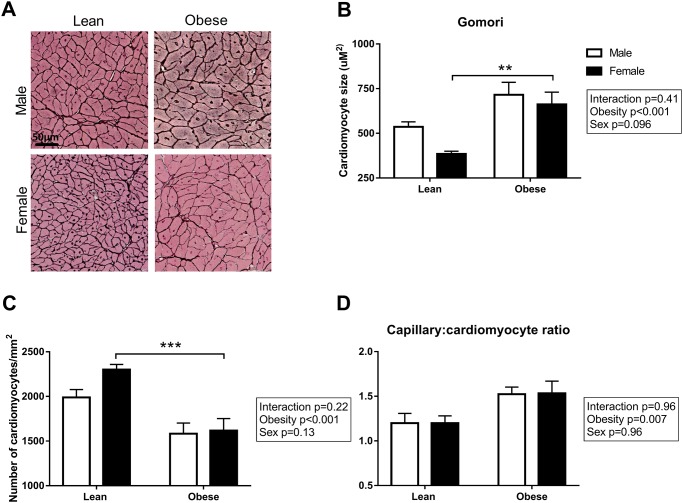
Obese female ZSF1 rats showed increased cardiomyocyte size.A) Representative images and B) quantification of cardiac hypertrophy stained with Gomori. C) Number of cardiomyocytes, D) capillary-to-cardiomyocyte ratio. N = 4-7/group. **P<0.01, ***P<0.001.